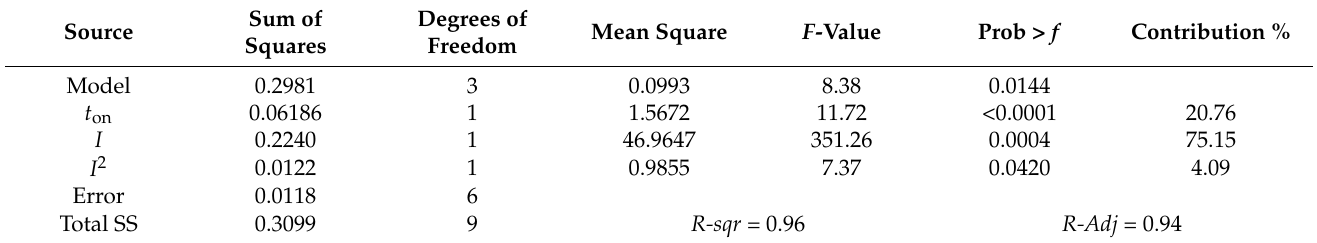
Table 9. ANOVA table for tool wear rate TW (after